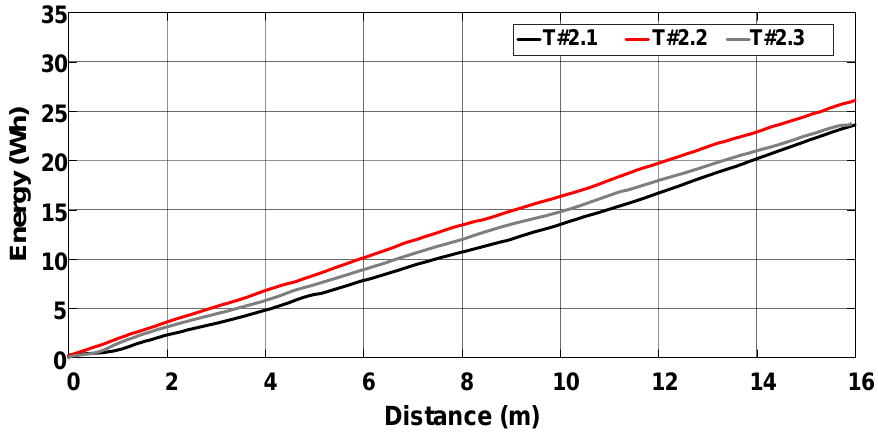
Figure 23. Power consumption during the trial sessions carried out on firm soil with the slip manually controlled by the operator.